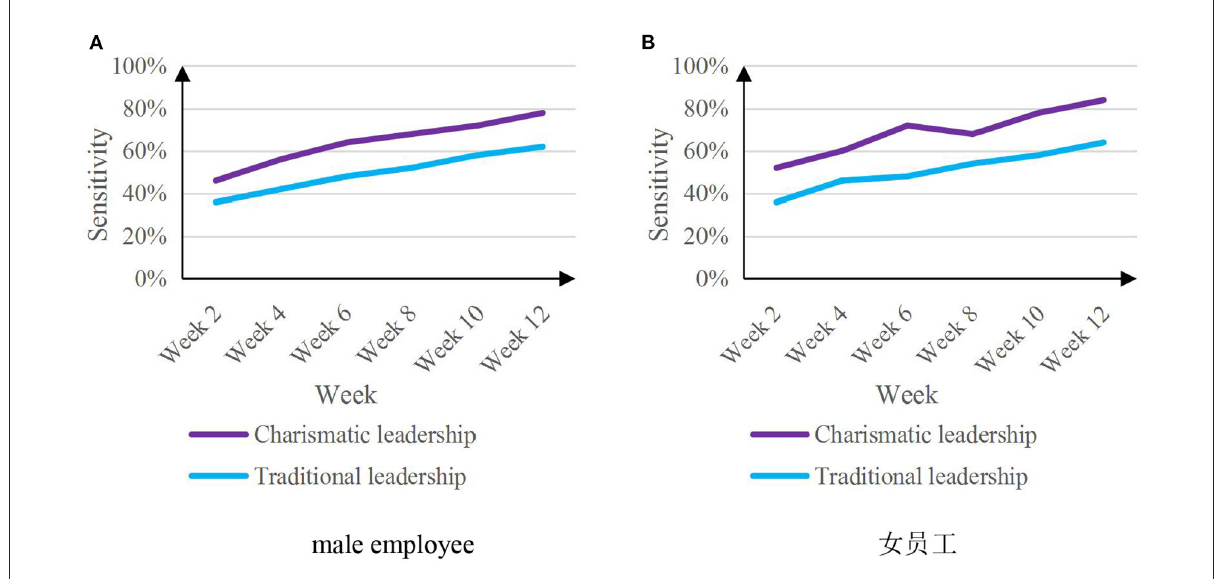
FIGURE10 Sensitivity map of leaders to employee needs. (A) Male employee. (B) 女 员 工